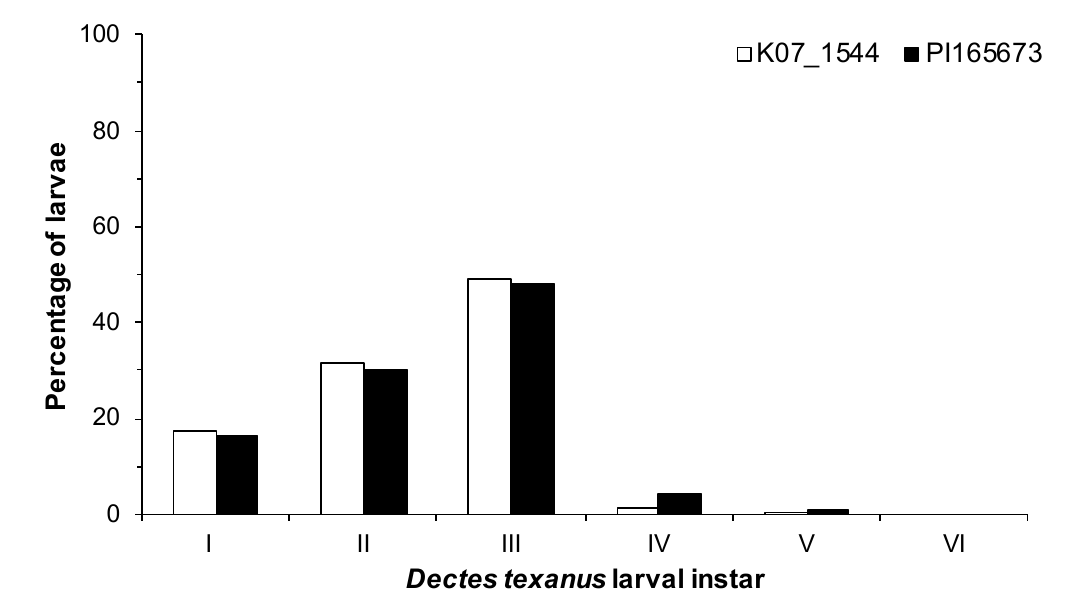
Figure 4. Percentage of Dectes texanus larvae per instar collected from plants of soybean genotypes K07-1544 and PI165673 at 21 d post infestation in 2012.